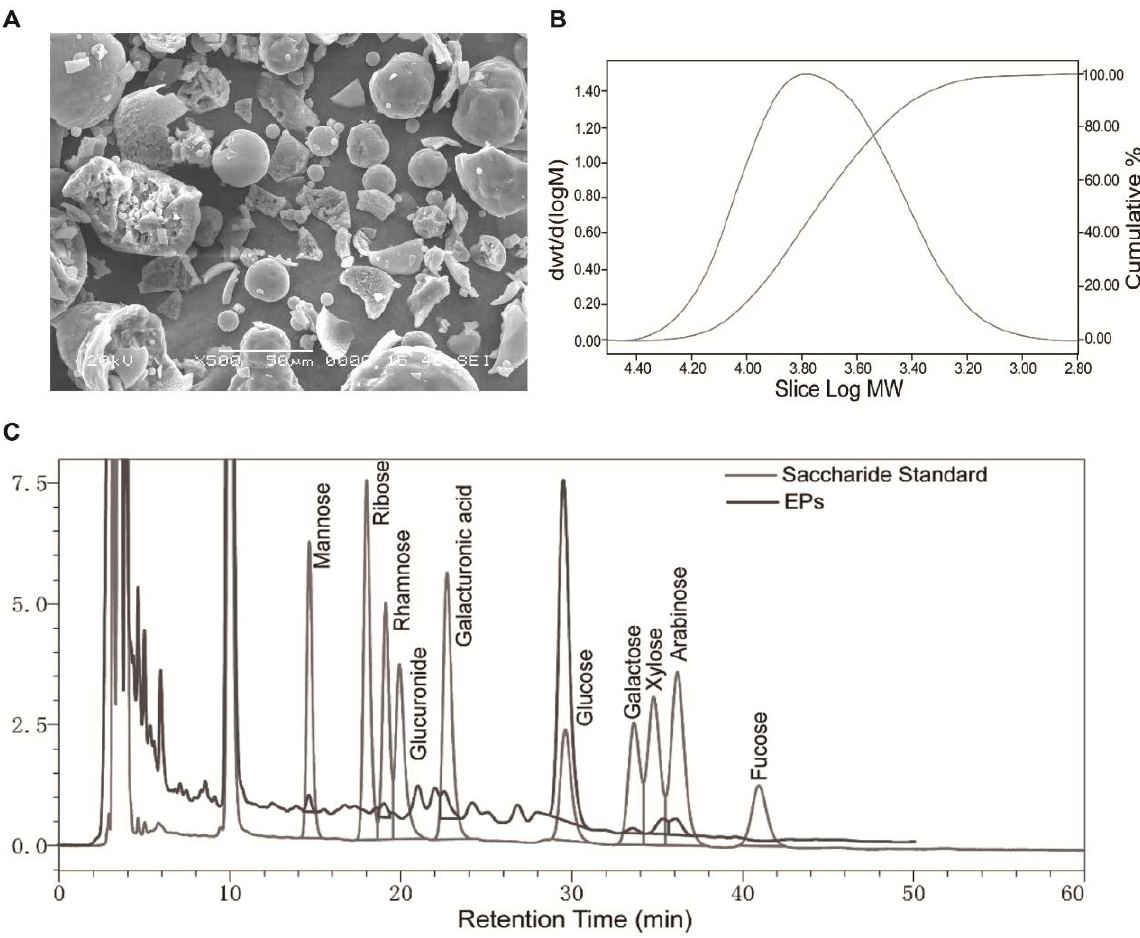
Figure 1. Morphology, monosaccharide composition, and molecular weight of EPs. ( A ) Scanning electron microscopy image of EPs. ( B ) Molecular weight distribution of EPs. ( C ) Elution profiles of the saccharide standard and EPs using high-performance liquid chromatography. Table 1. The monosaccharide composition of EPs.